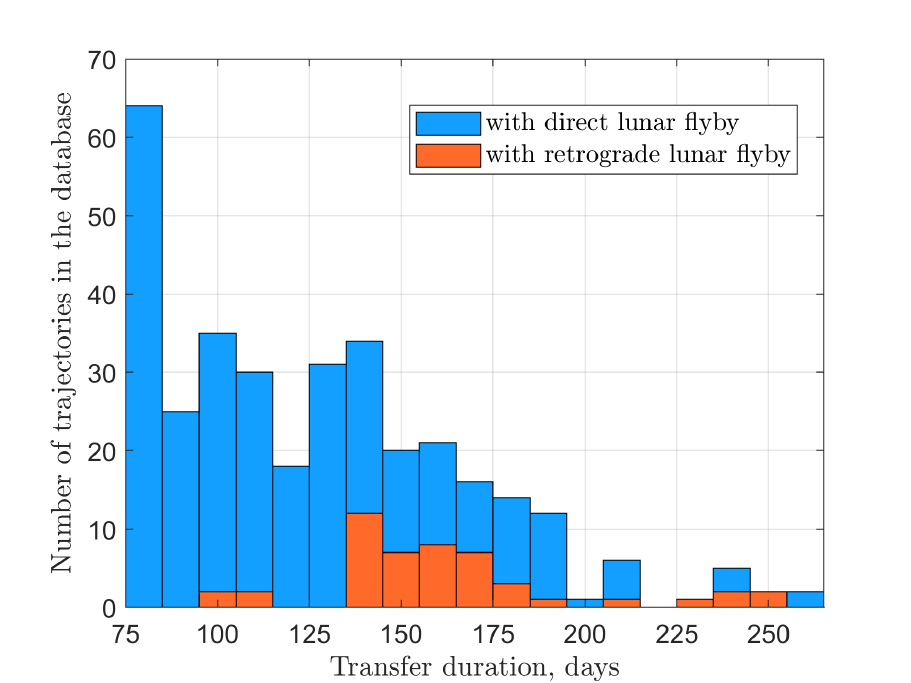
Figure 20. Distribution of the total transfer duration for SALT trajectories including a lunar flyby. Three examples of SALT trajectories before and after adaptation for each type of Sun-assisted transfers are depicted in Figures 21–23. In all the examples, the TLI burn magnitude changes by at most several m/s and its phase shift is in the order of a couple of degrees. The apogee correction maneuvers vary from 0.6 m/s for the second-type (direct flyby) trajectory to 34.5 m/s for the third-type (retrograde flyby)